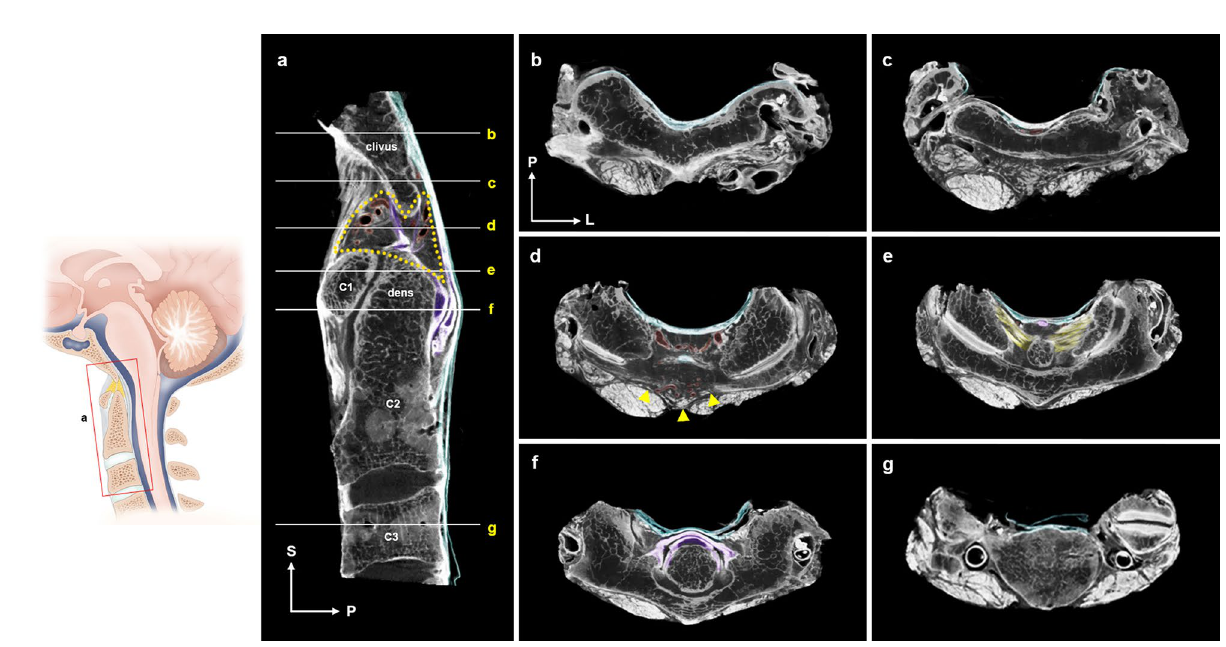
Figure 2. Micro-CT images of the craniovertebral junction (CVJ). ( a ) Mid-sagittal view of the CVJ. The supradental space (yellow dotted line) with dilated venous plexus (red area). ( b ) Coronal view of the firmly attached tectorial membrane (TM) to the periosteum of the superior clivus (blue area). ( c ) Coronal view of inferior clivus. Vessels (red area) from the infra-clival region invaded the niche formed by the TM departing from the inferior clivus. ( d ) The supradental space between clivus and dens. Note profound venous plexus (red area) in hypointense adipose tissues posterior to the anterior atlantooccipital membrane (arrowheads). ( e ) Ligamentous structures at the level of apex of the dens are attached by an alar ligament (yellow area). The superior crus of the cruciate ligament (purple area) is anterior to the TM. ( f ) The transverse ligament of cruciate ligament posterior to the hypertrophied cartilage of dens (purple area) and medial osculation between the TM and dura mater (blue area). ( g ) Medial attachment of the posterior longitudinal ligament to the body of C3 and separated spinal dura mater (blue